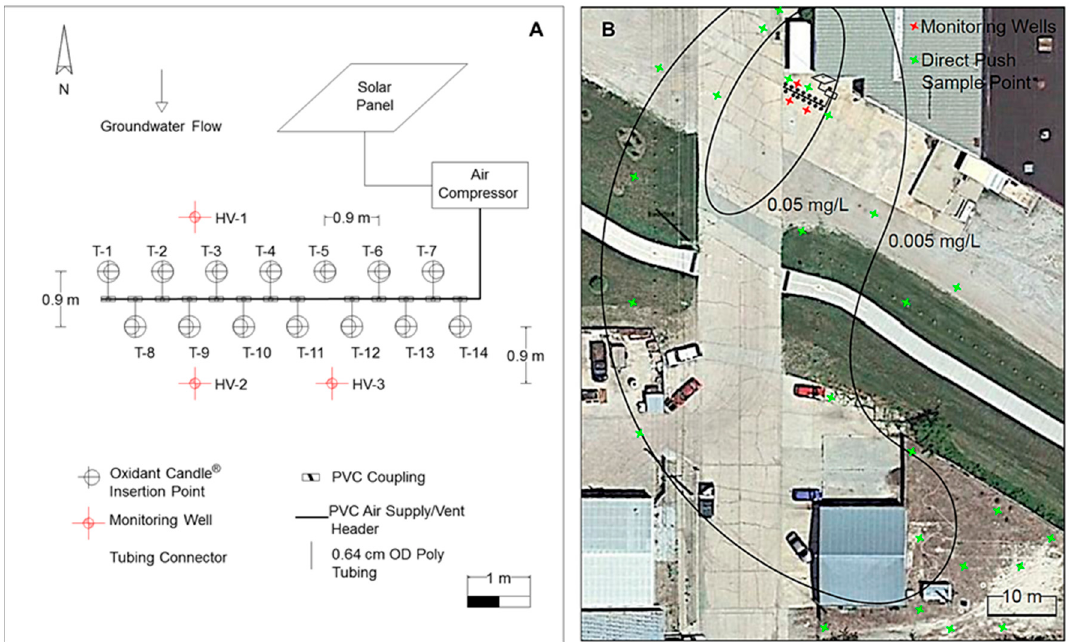
Figure 9. ( A ) Plot plan of the Hoover site showing the location of direct-push oxidant candles with aeration and ( B ) plan view of the Hoover site showing locations of TCE, BTEX and 1,4-dioxane plume and oxidant drive points (circled).